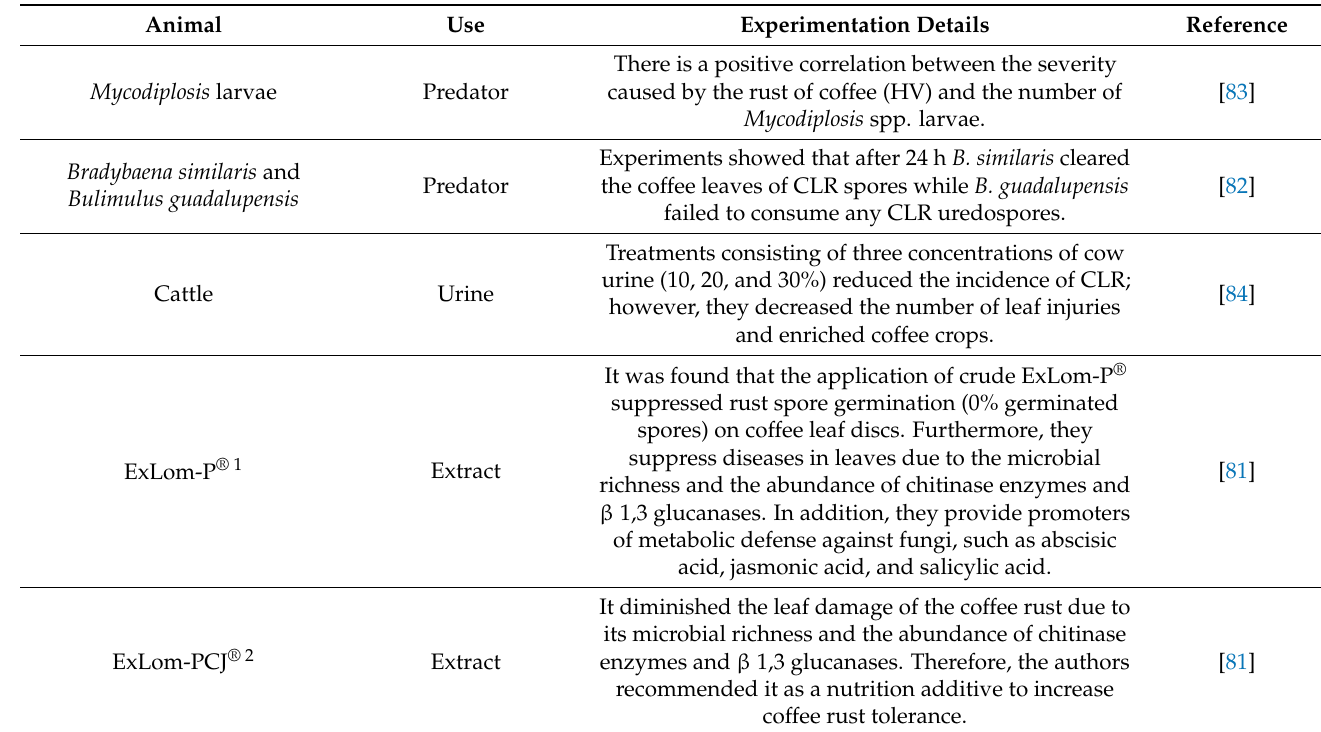
Table 3. Alternative use of animals for coffee rust